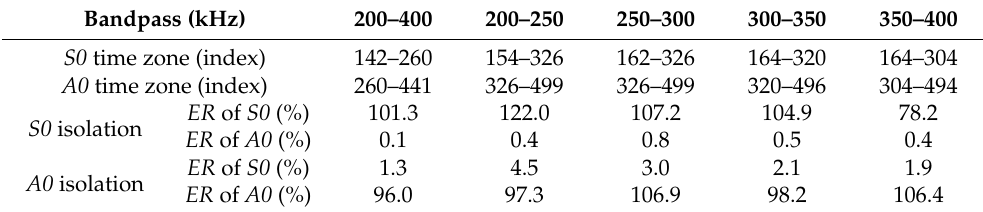
Table 2. Effectiveness of the mode filter in terms of energy